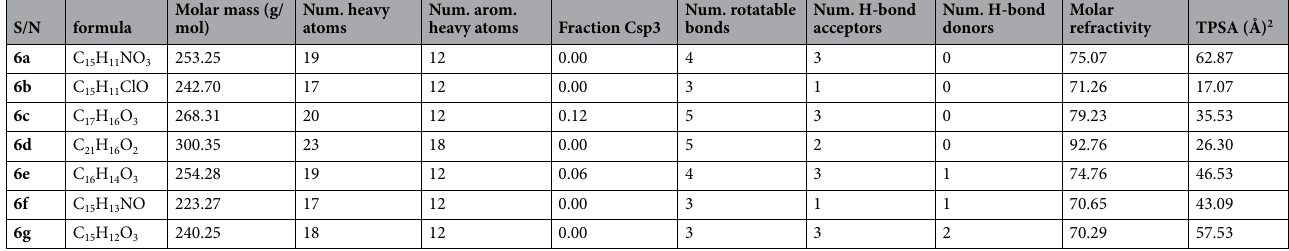
Table 1. Physicochemical